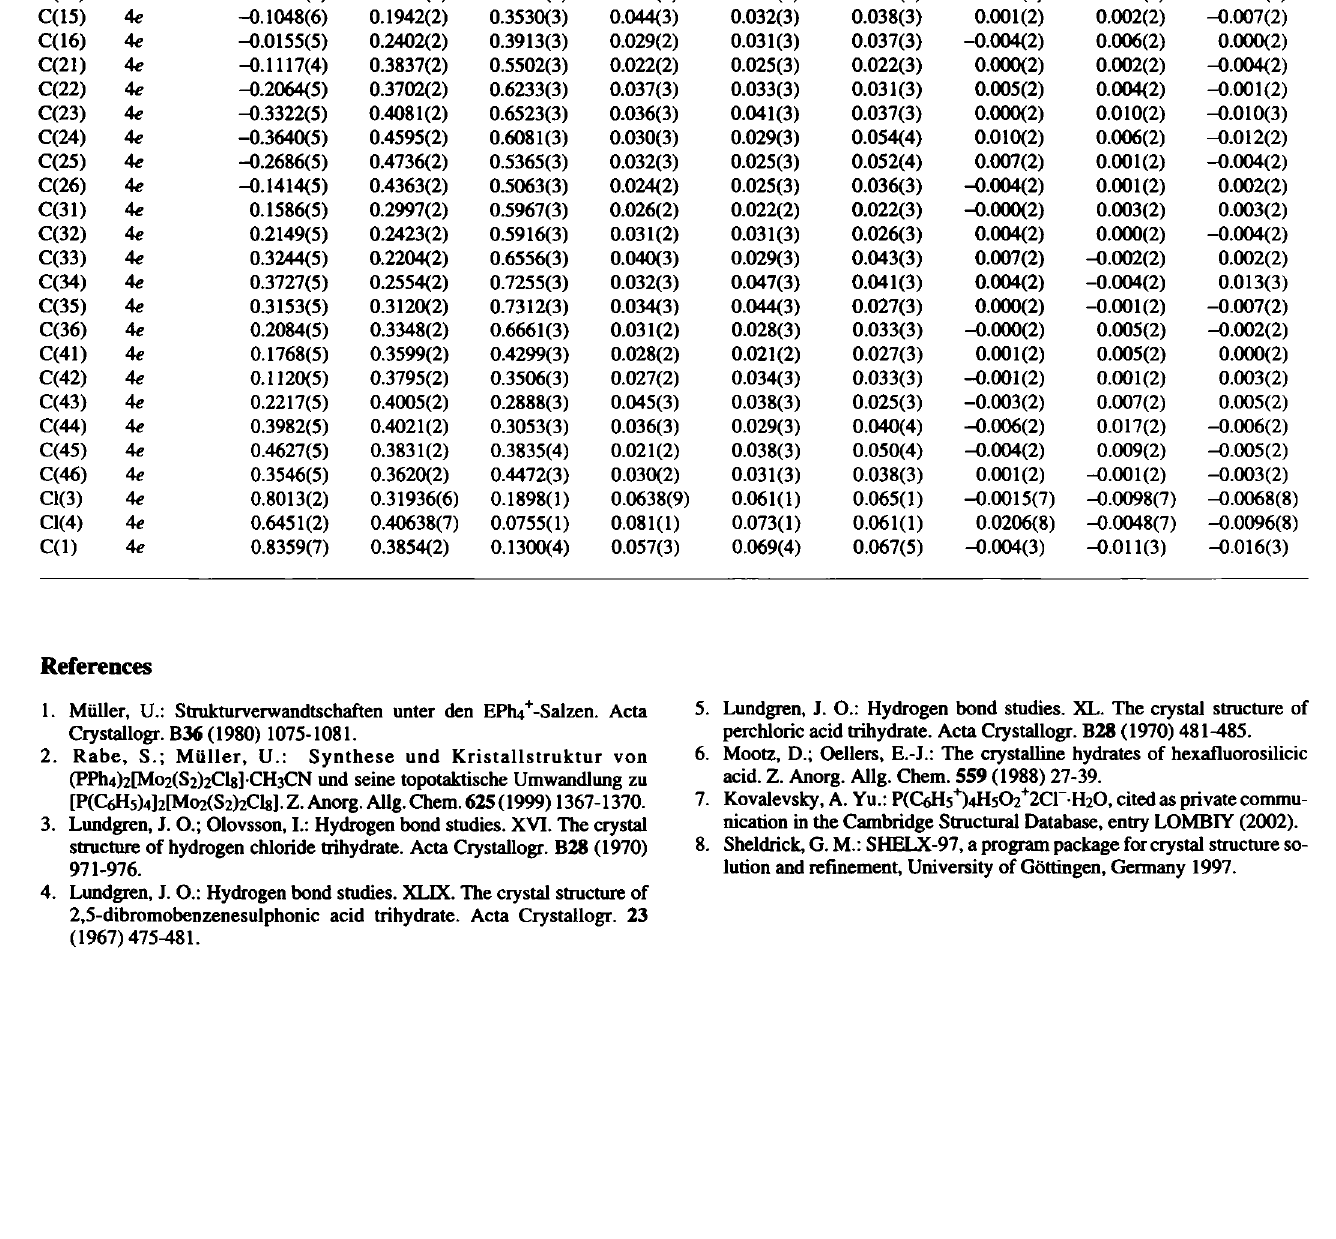
Table 3. Atomic coordinates and displacement parameters (in À 2